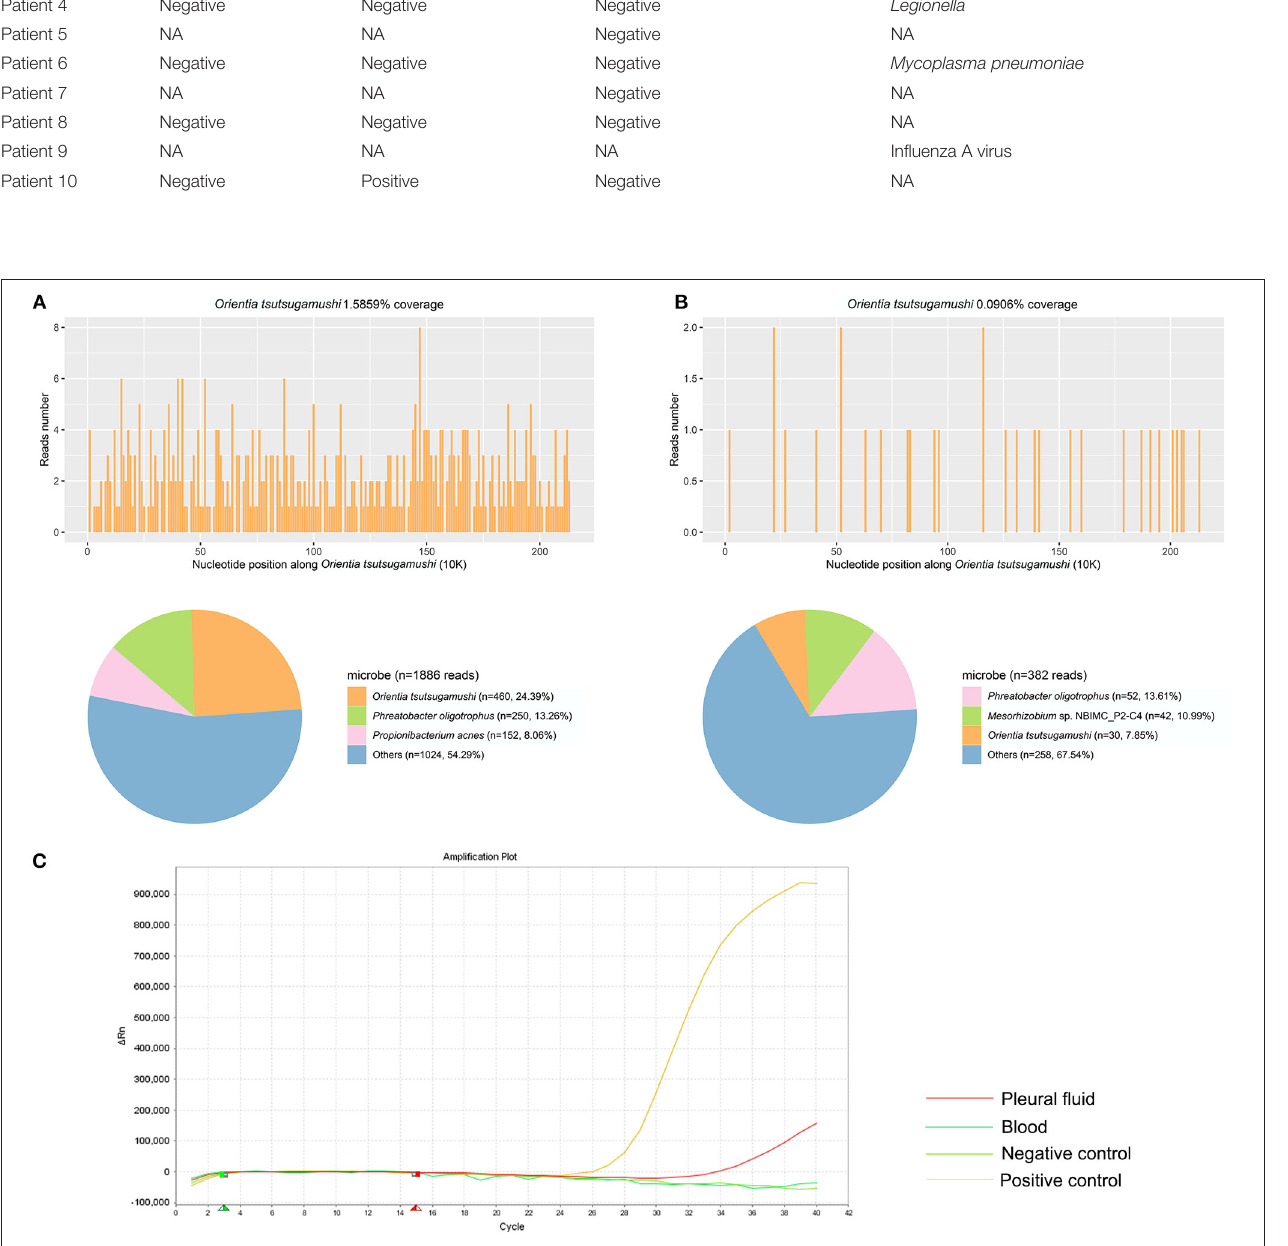
Frontiers in Public Health |